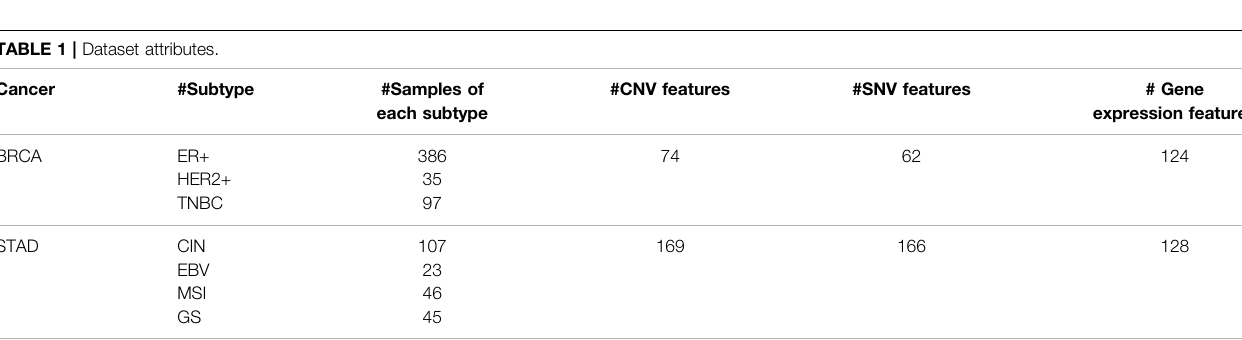
TABLE 1 | Dataset